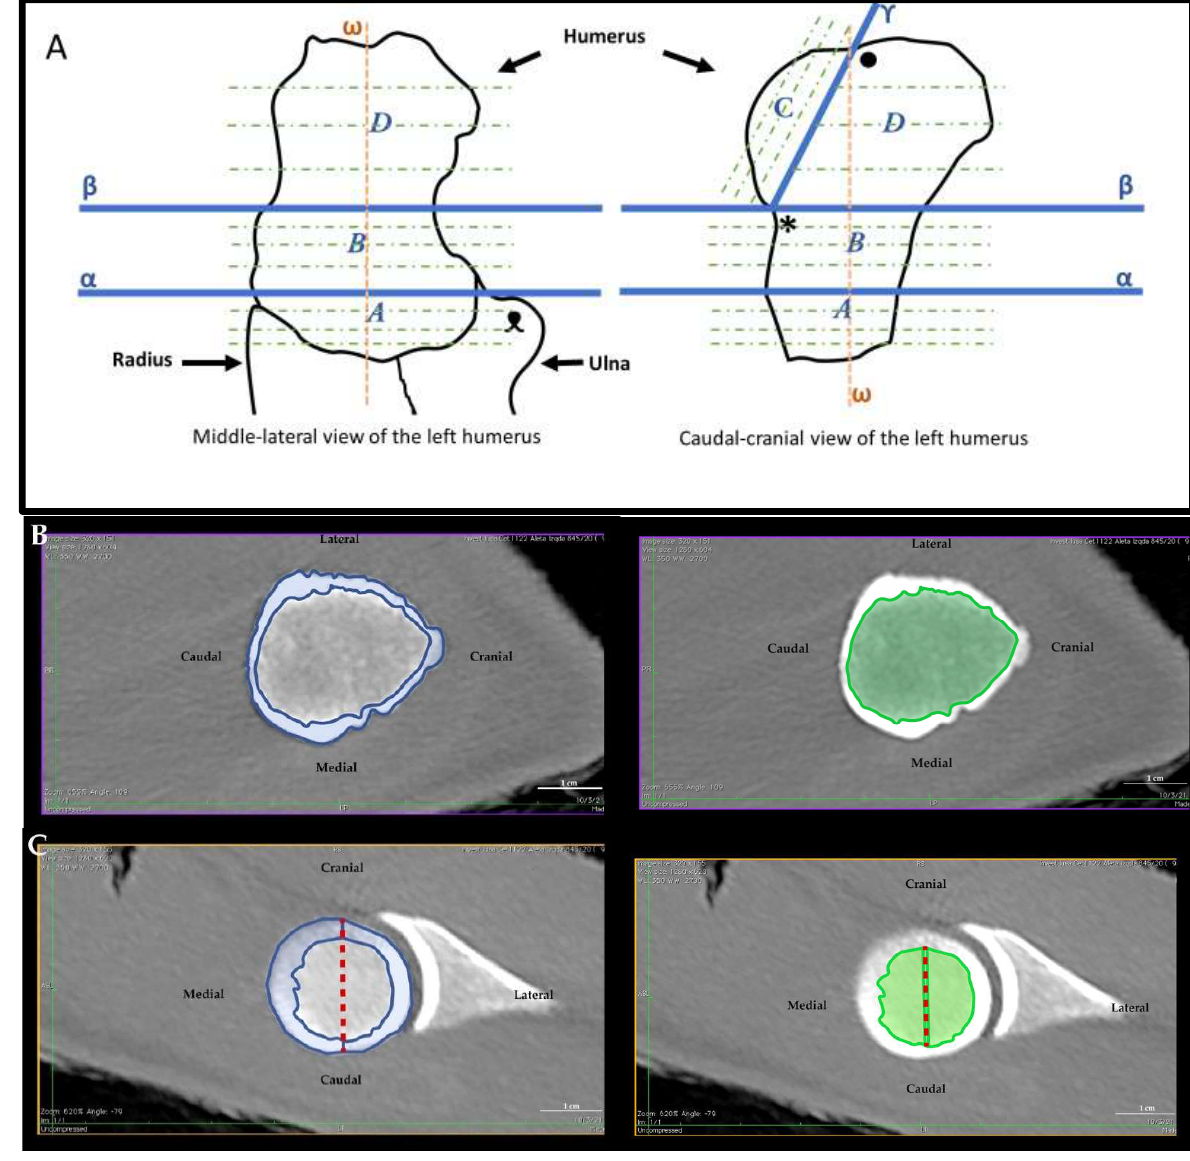
Figure 1. Illustration of the applied protocol. ( A ): Schematic representation of the applied protocol to obtain the four portions of the humerus: it shows the longitudinal axis of the humerus (ω), the plane (β) passing through the neck of the humerus (*), and the plane (α) passing tangentially to the olecranon of the ulna ( ᴥ ). Proximally, the plane (Υ) passes through the neck of the humerus (*) and the notch (•) between the head of the humerus and the tubercle. These planes delimit the portions: ( A ) distal epiphysis; ( B ) body; ( C ) head of the humerus; ( D ) proximal epiphysis consisting entirely of the tubercle. The green dashed lines represent the various sagittal planes equidistant in the different portions of the various measurements. ( B ): Example of a humeral section (third transversal section of the humeral body of Atlantic spotted dolphin). The area corresponding to the cortical bone can be seen highlighted in blue, and the area corresponding to the trabecular bone in green. ( C ): Example of a humeral head section (second transversal section of the humeral head of Atlantic spotted dolphin). The section was divided into lateral and medial aspects following the midline (red dashed line). In blue are the two areas of the cortical bone (lateral and medial). In green are the two areas of the trabecular bone (lateral and